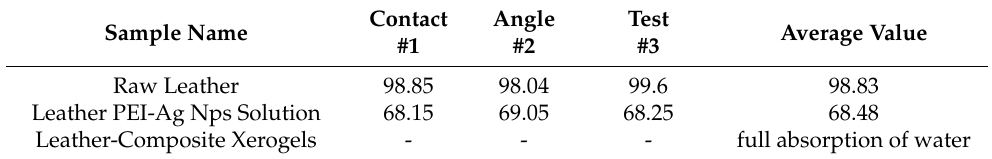
Table 6. Water contact angle properties of the three studied leather samples.